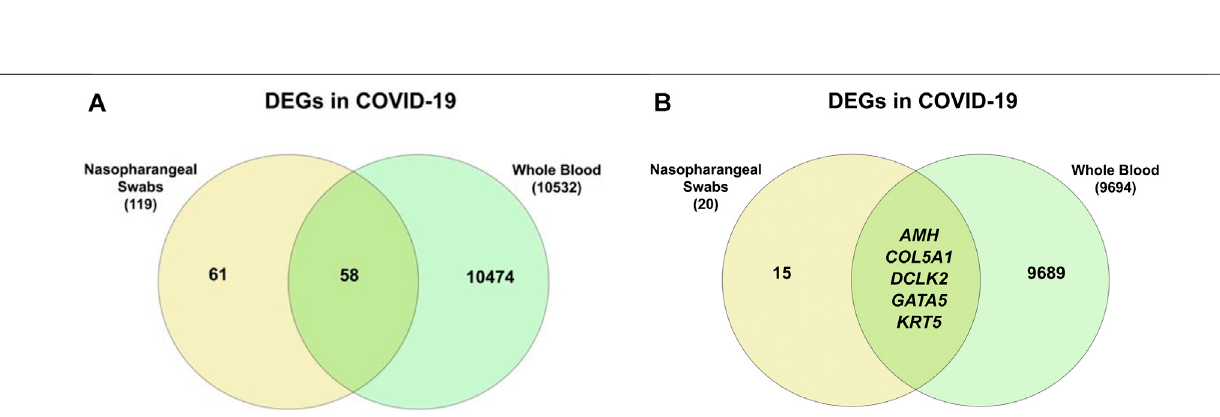
FIGURE10| CommonDEGsbetweencontrols,COVID-19patients,andpatientsfromviralornonviralacuterespiratoryillnessfrom (A) nasopharyngealswabsand (B) whole blood samples.